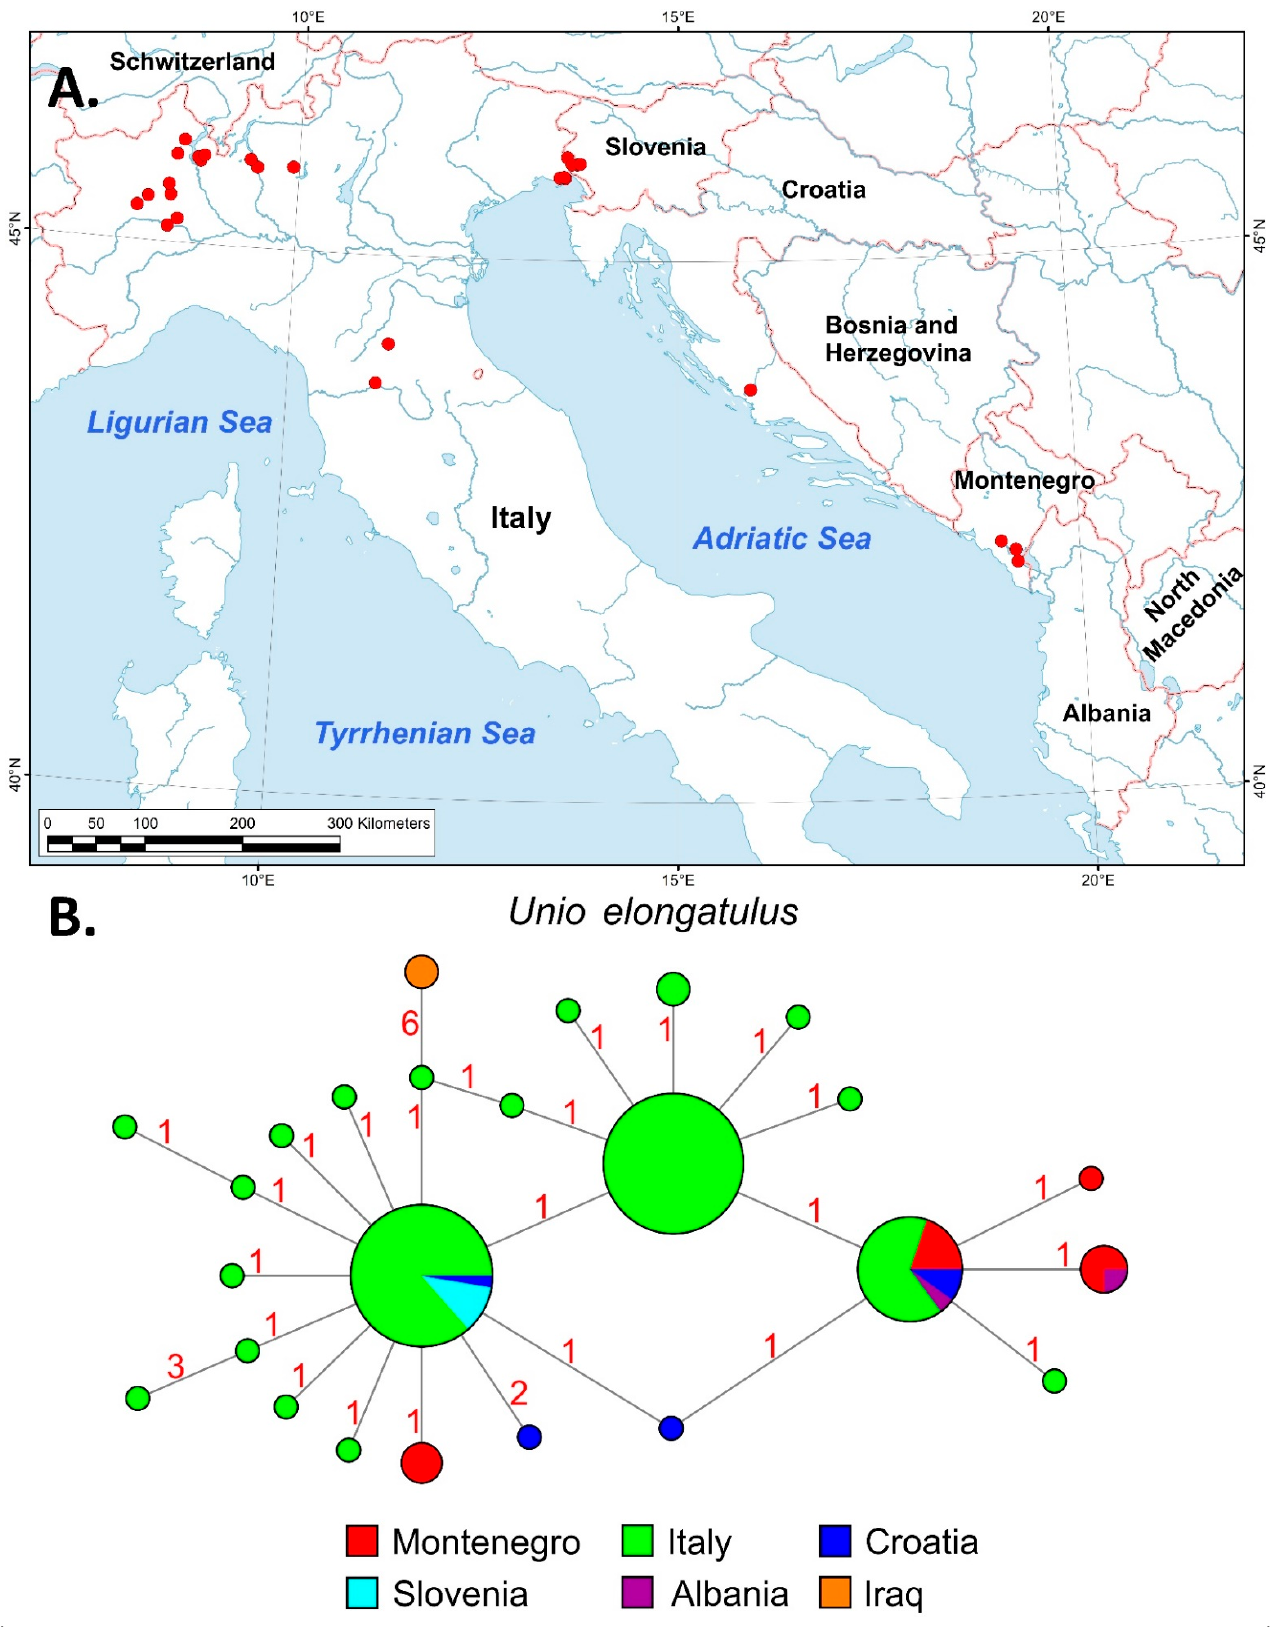
Figure 5. Distribution and phylogeography of Unio elongatulus : range map ( A ) and median-joining network ( B ).